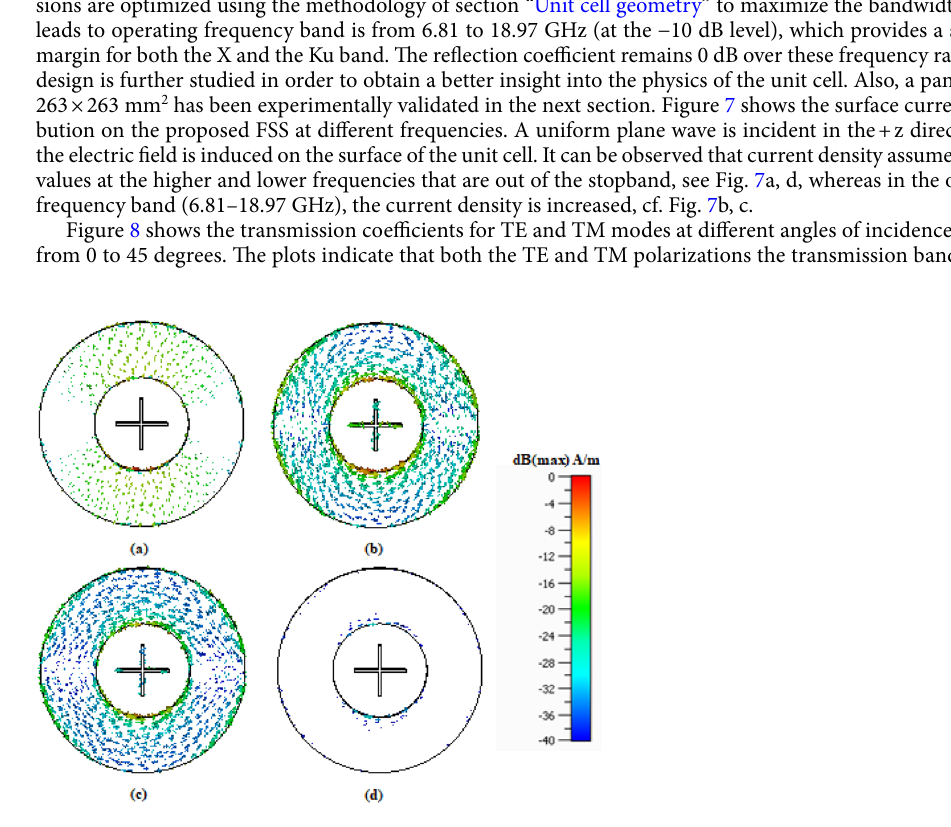
Figure 7. Surface current distribution on the FSS Design 1 at ( a ) 5 GHz, ( b ) 10 GHz, ( c ) 15 GHz, ( d ) 20